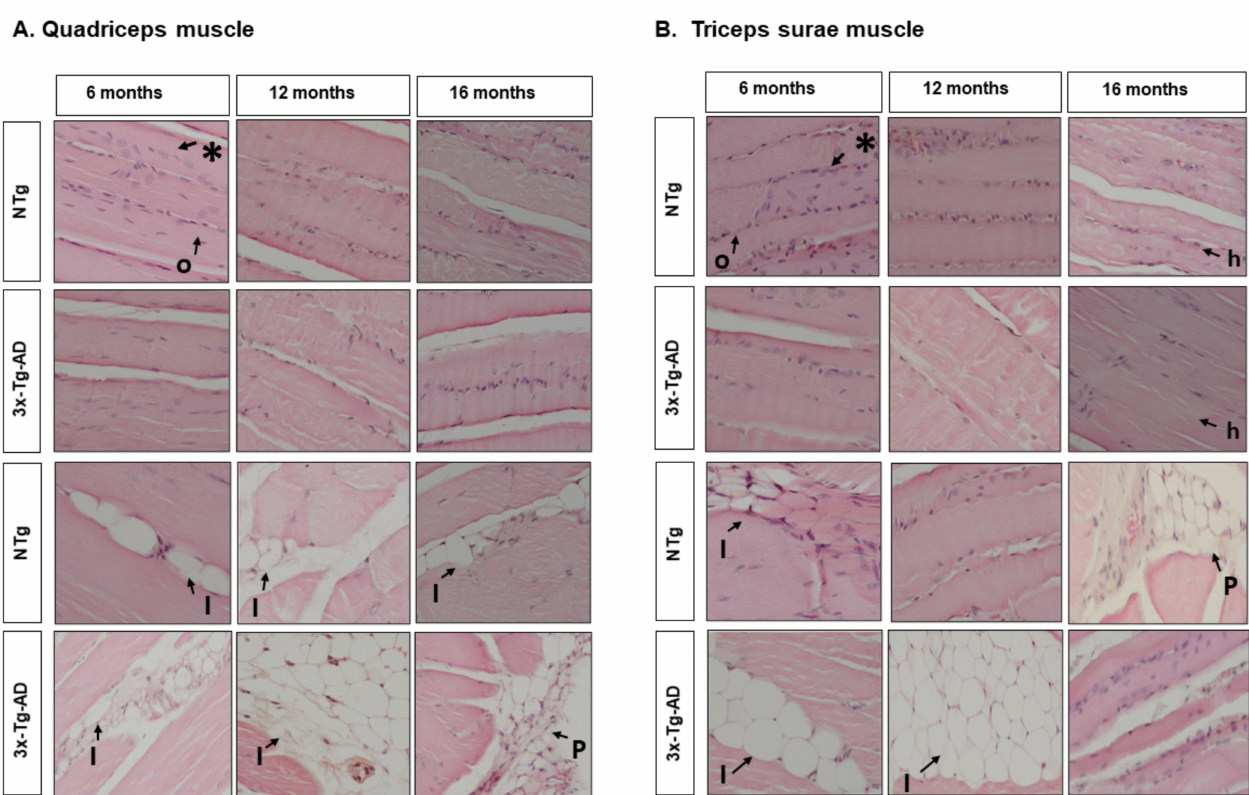
Figure 6. Morphological comparison of muscle tissue in normal and AD-pathological aging. Hematoxylin and eosin-stained horizontal sections of muscles. ( A ) Quadriceps muscle; ( B ) Triceps surae muscle. Representative H&E images of longitudinal skeletal muscle at 6, 12, and 16 months. Symbols indicate the morphological features, as follows: *—Peripheral nuclei; o—homogeneous fibre distribution; h—heterogeneous fibre distribution; I—intramuscular adipose tissue; P—peripheral adipose tissue. The images were taken with 20 × objective lens; the scale bar represents 0.32 µ